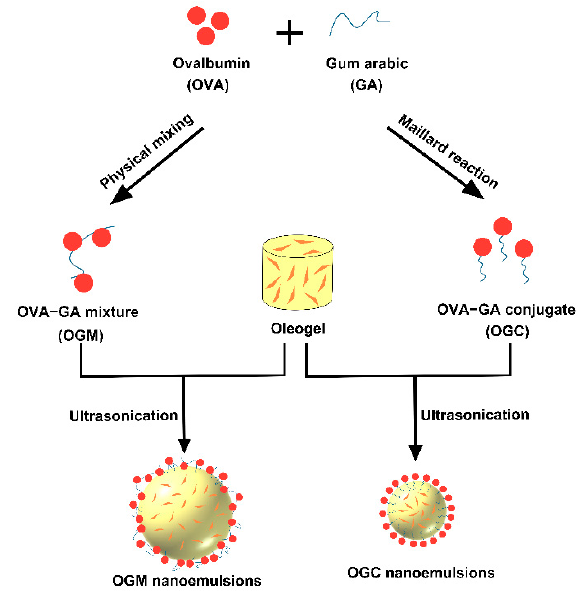
Figure 1. Schematic illustration of the fabrication of oleogel-based nanoemulsions.